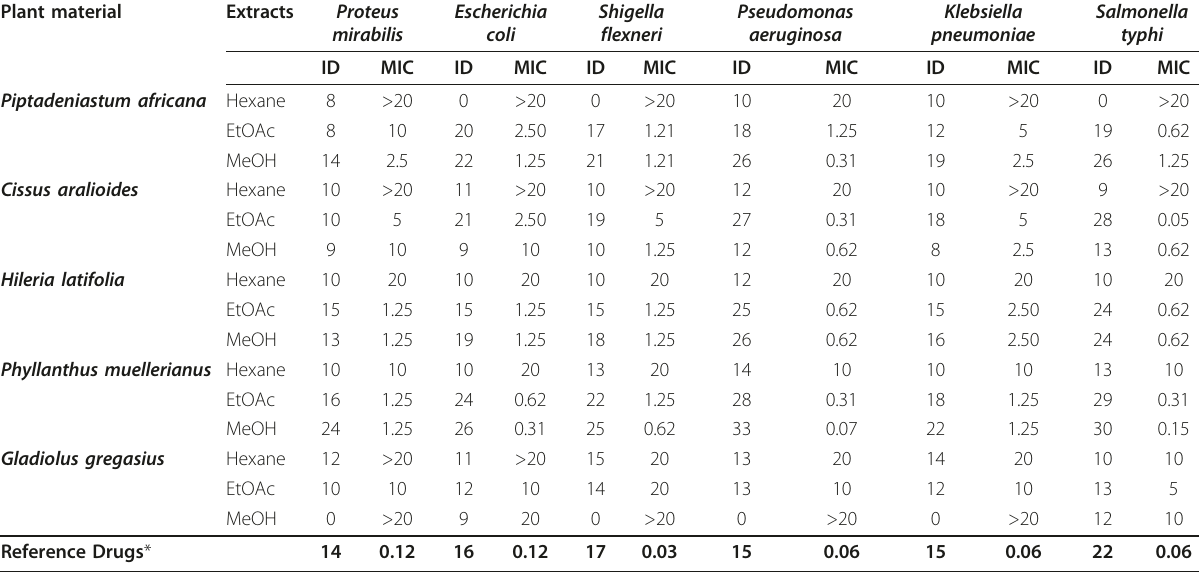
Table 2 Inhibition zone diameters (ID in mm) and minimal inhibitory concentration (MIC in mg/ml) of hexanic,